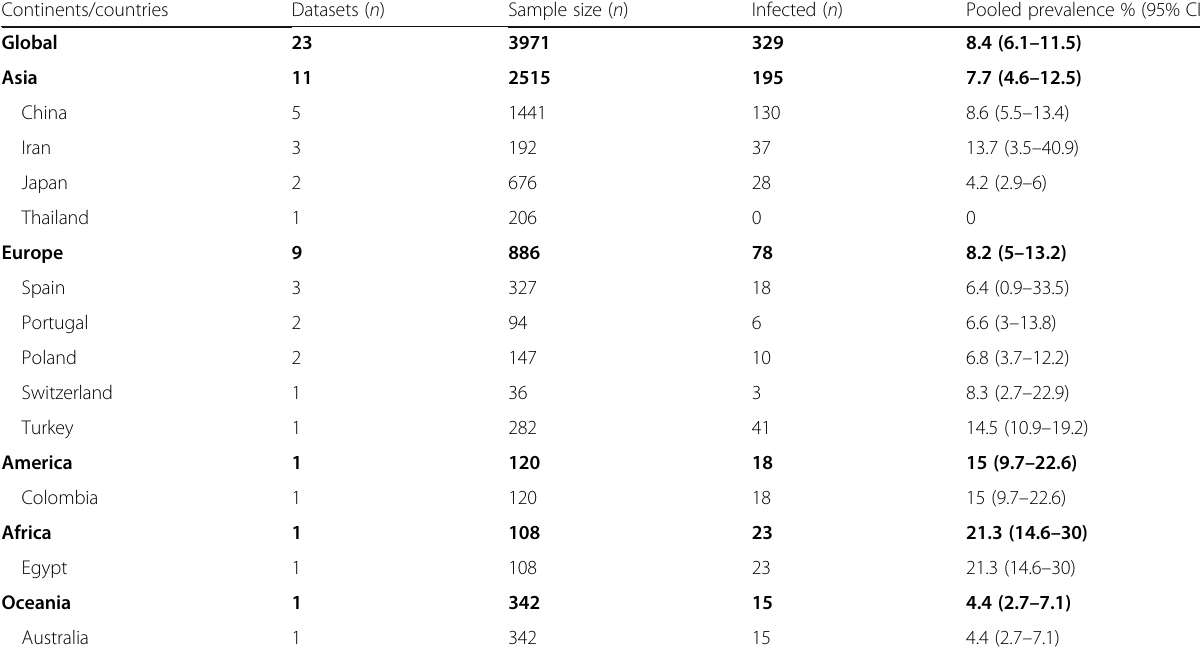
Table 2 Subgroup analysis of continents and countries based on molecular methods in dogs Continents/countries